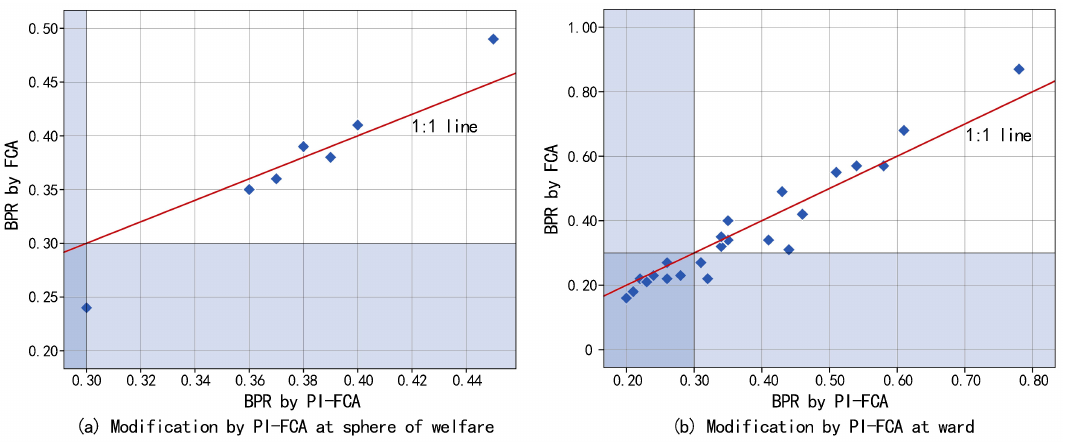
Figure 5. Comparative analysis to illustrate modification of the BPR by the PI ‐ FCA: ( a ) sphere of welfare, and ( b ) ward.